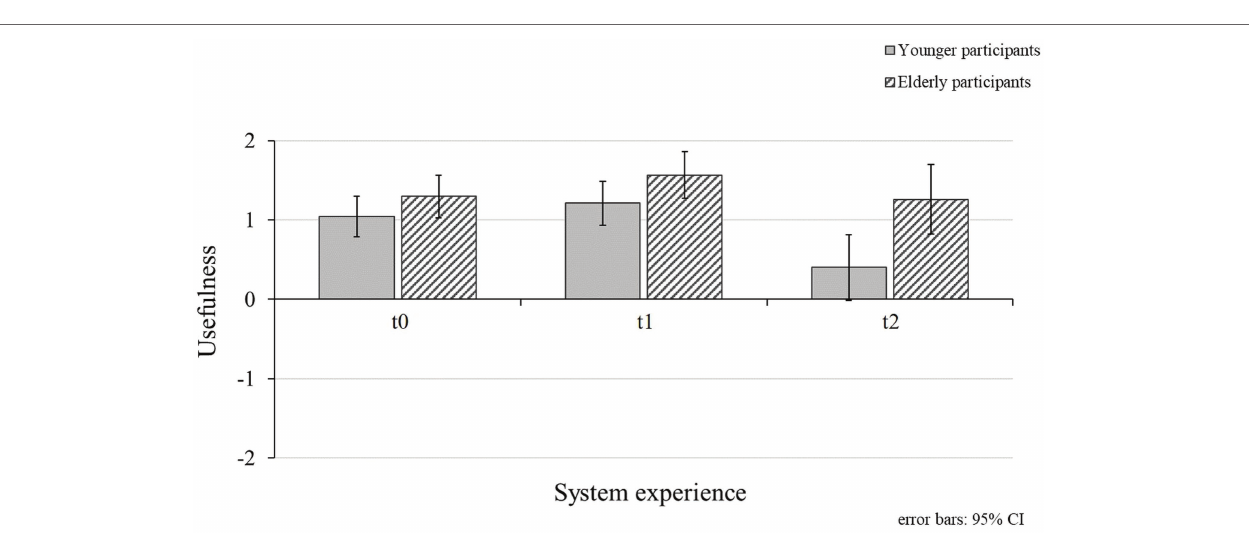
after experiencing eHMI malfunctions ( M t2 = 4.04, SD t2 = 1.39;